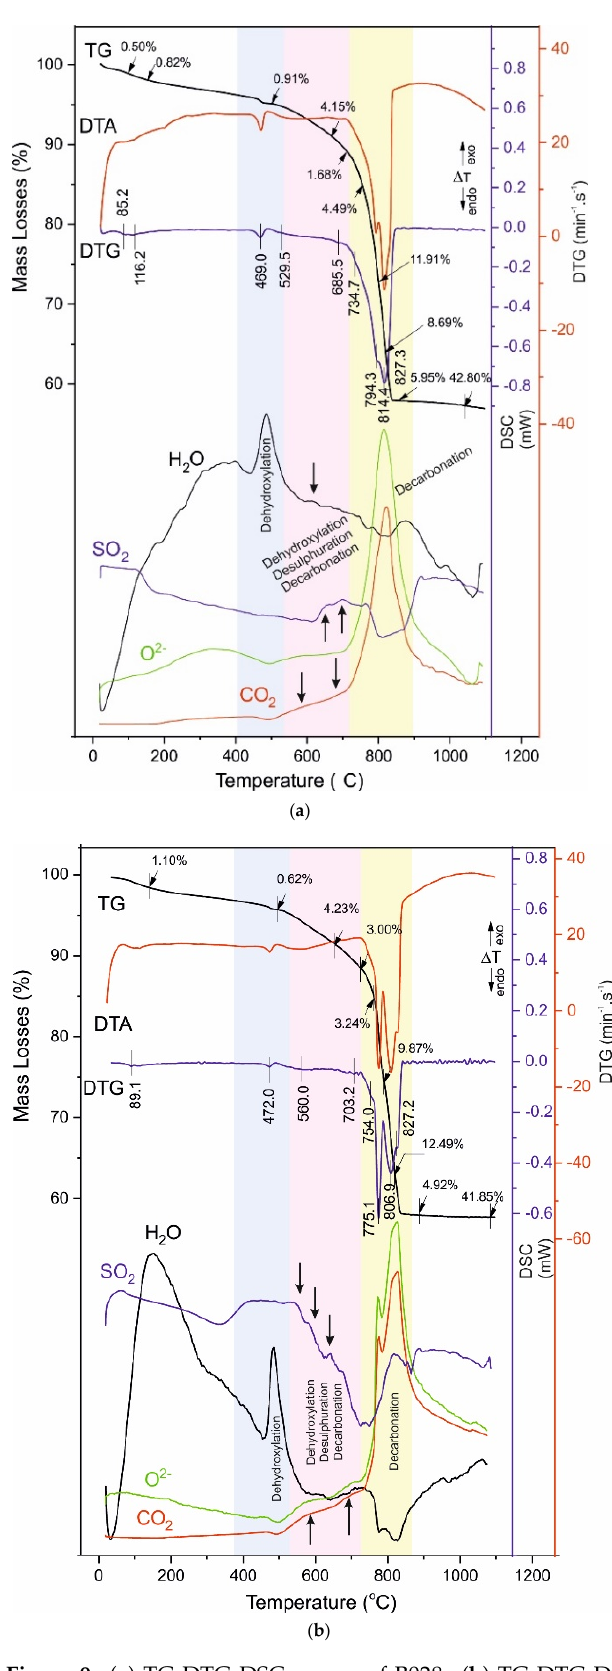
Figure 9. ( a ) TG-DTG-DSC curves of B028. ( b ) TG-DTG-DSC curves of B120. The temperature intervals in which thermal processes take place are marked with a different color background.